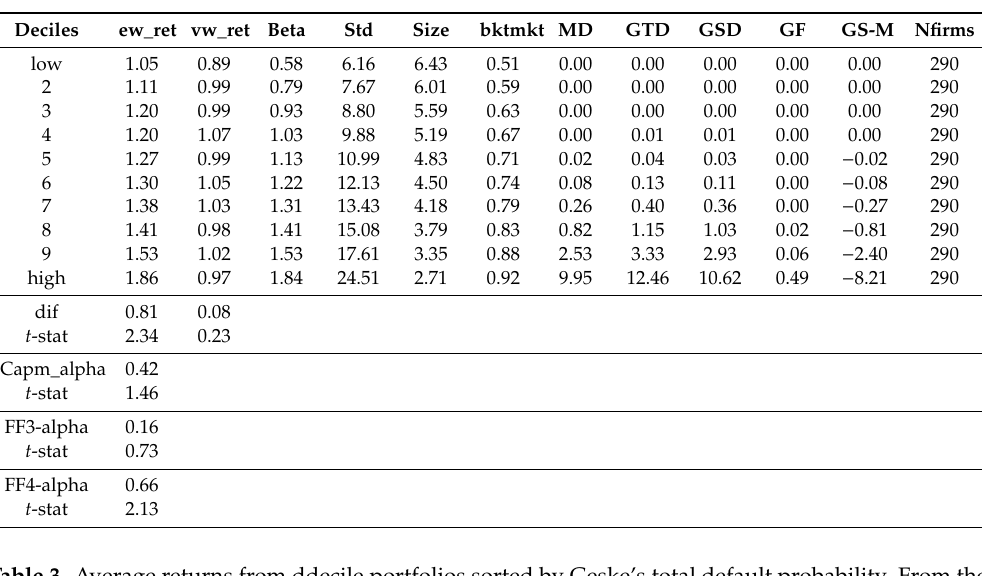
Table 2. Average returns from decile portfolios sorted by Merton’s default probability. From the data for July 1963 to December 2013, at the end of each month, we used the most recently calculated Merton’s default probability for each firm to sort all stocks into deciles. We then calculated the equally weighted and value-weighted returns over the next month. The returns are the average monthly returns over the sample period. Portfolio 1 is the portfolio with the lowest default risk and Portfolio 10 is the portfolio with the highest default risk. High-Low is the di ff erence between the high and low default risk portfolios. t -values are calculated from Newey-West standard errors. Alphas are calculated using the CAPM, the three-factor Fama-French, and the four-factor model (Fama-French three-factor plus momentum).